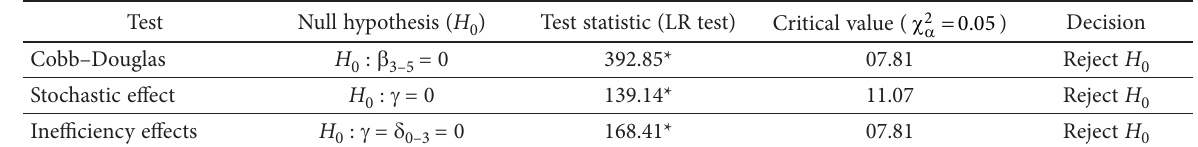
Table 2. Results of hypotheses